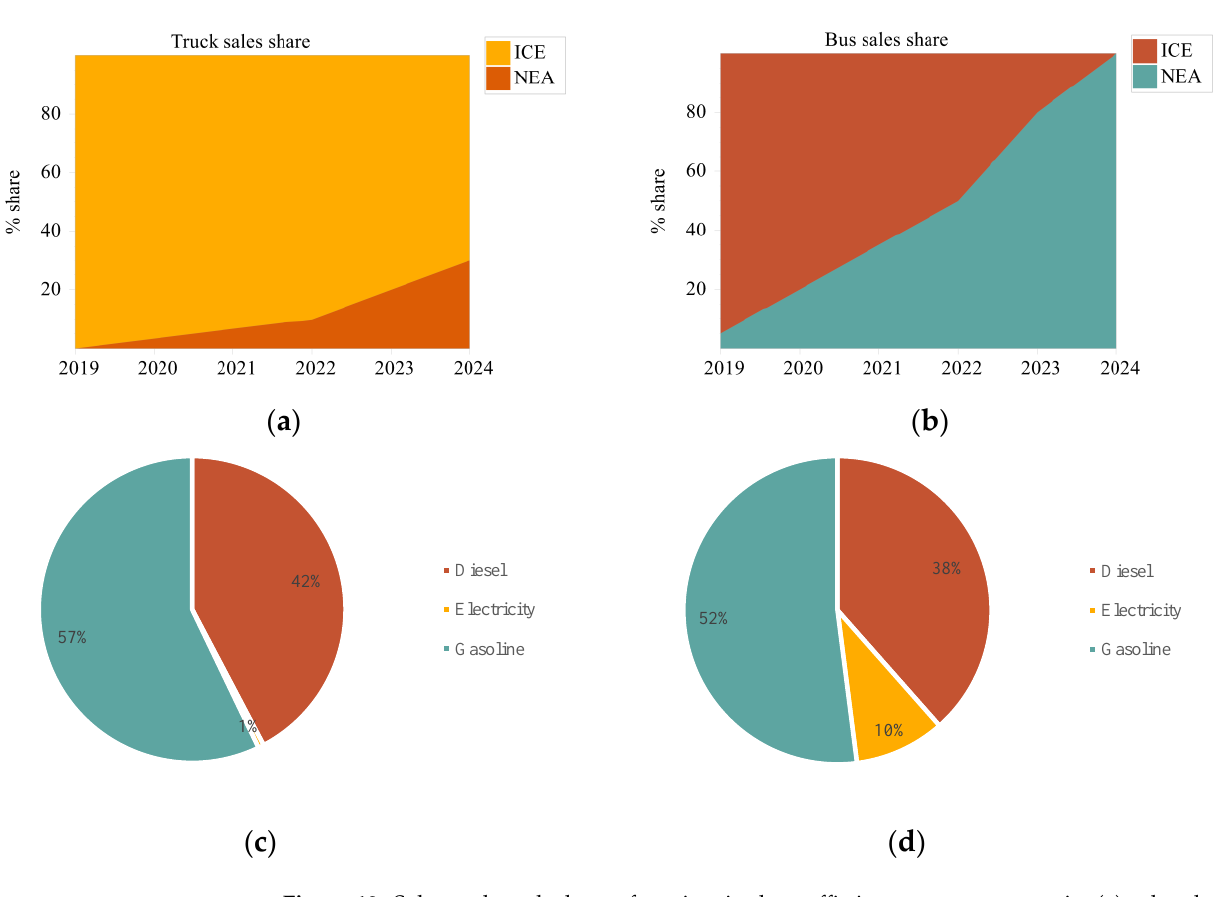
Figure 10. Sales and stock share of carriers in the traffic improvement scenario; ( a ) sales share of trucks; ( b ) sales share of buses; ( c ) stock share of the three energy vehicles in 2019; ( d ) stock share of the three energy vehicles in 2024).